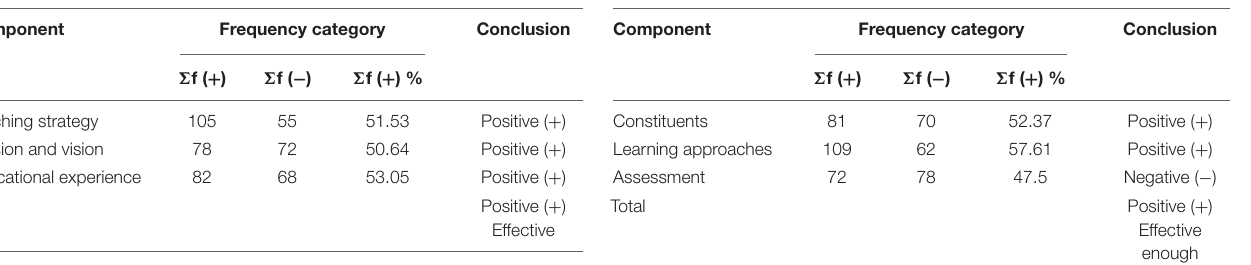
TABLE 5 | T -score analysis of the process variable component.